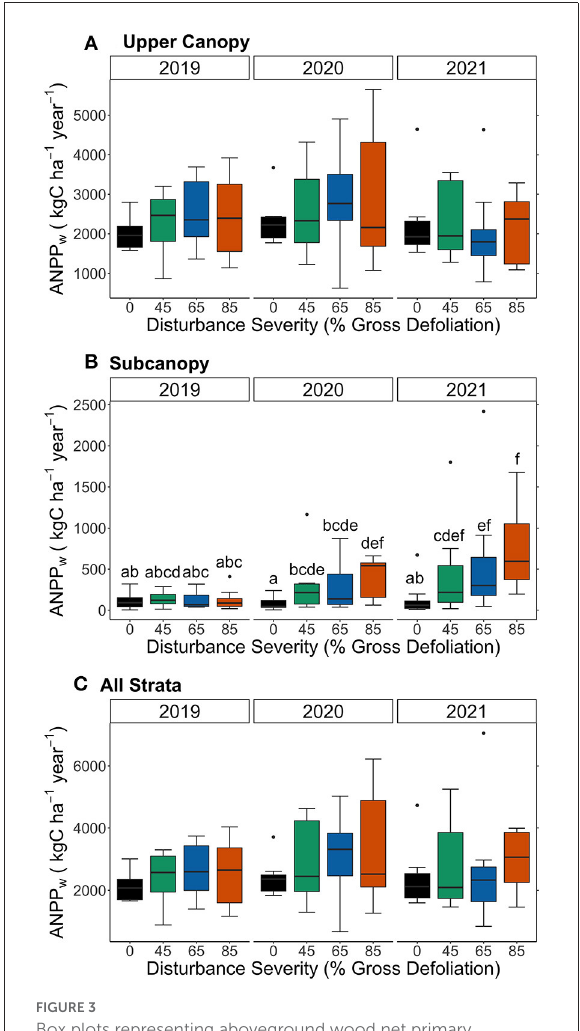
FIGURE3 Box plots representing aboveground wood net primary production (ANPP w ) in the upper canopy (A) , subcanopy (B) , and sum of both upper canopy and subcanopy (C) . Middle horizontal lines represent the median ANPP w , boxes represent the interquartile ranges, and the whiskers represent the maximum and minimum subplot values for ANPP w . Colored boxes represent disturbance severity, or percent gross defoliation, which is repeated in each stratum for years 2019–2021. Non-overlapping letters in (B) indicate significant pairwise differences between disturbance severities ( p < 0.05). In the upper canopy and both strata combined, there was no significant effect of disturbance severity (A,C)